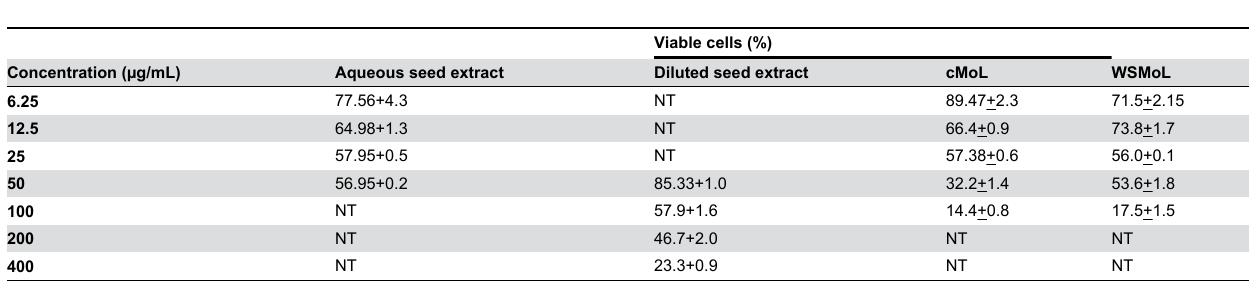
Table 2. Effect of M. oleifera seed extracts and lectins on the viability of LPS-stimulated peritoneal